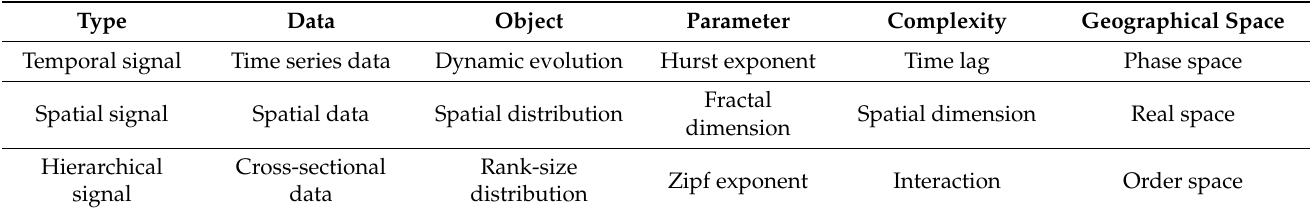
Table 1. Three types of signals and uses for scientific